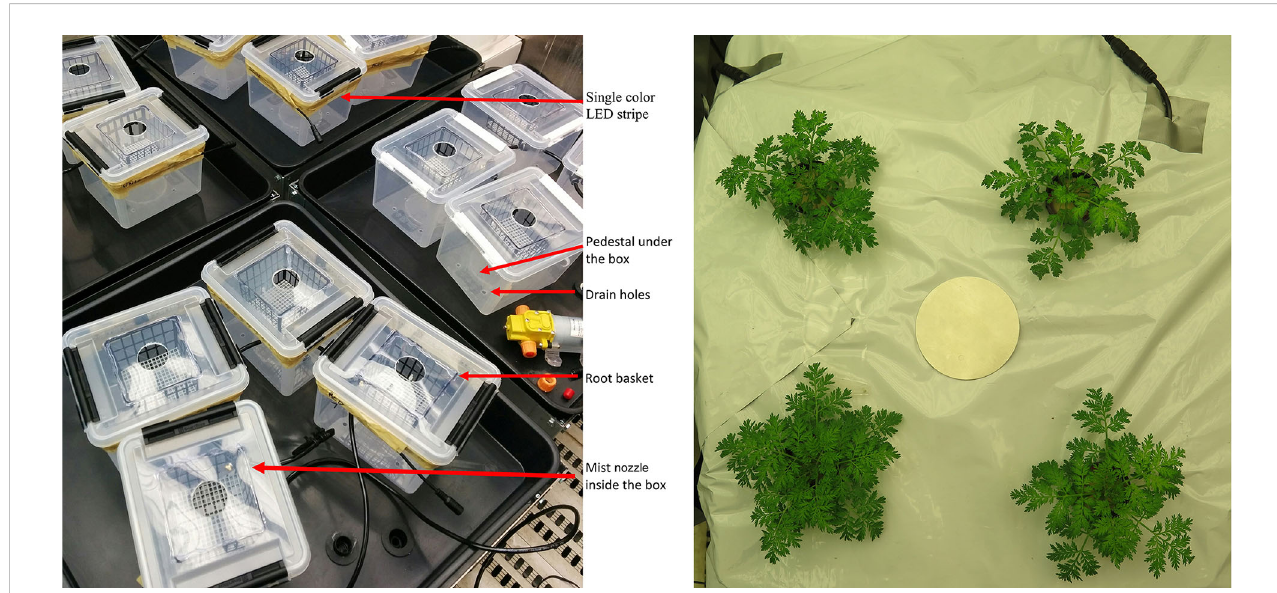
FIGURE 1 The experimental setup. The roots of Artemisia annua and Hypericum perforatum were illuminated continuously under different unicolored wavelength by fl exible light-emitting diode (LED)-stripes fi xed outside a transparent plastic container in a high pressure aeroponics system for 14 and 19 days, respectively (A) . The 4 replications were covered with light-impermeable foil including the tray that captured the drained nutrient solution (B) to investigate the effect of the root illumination stimulus on plant developmental parameters, root hair density and length and the enhancement of secondary metabolite